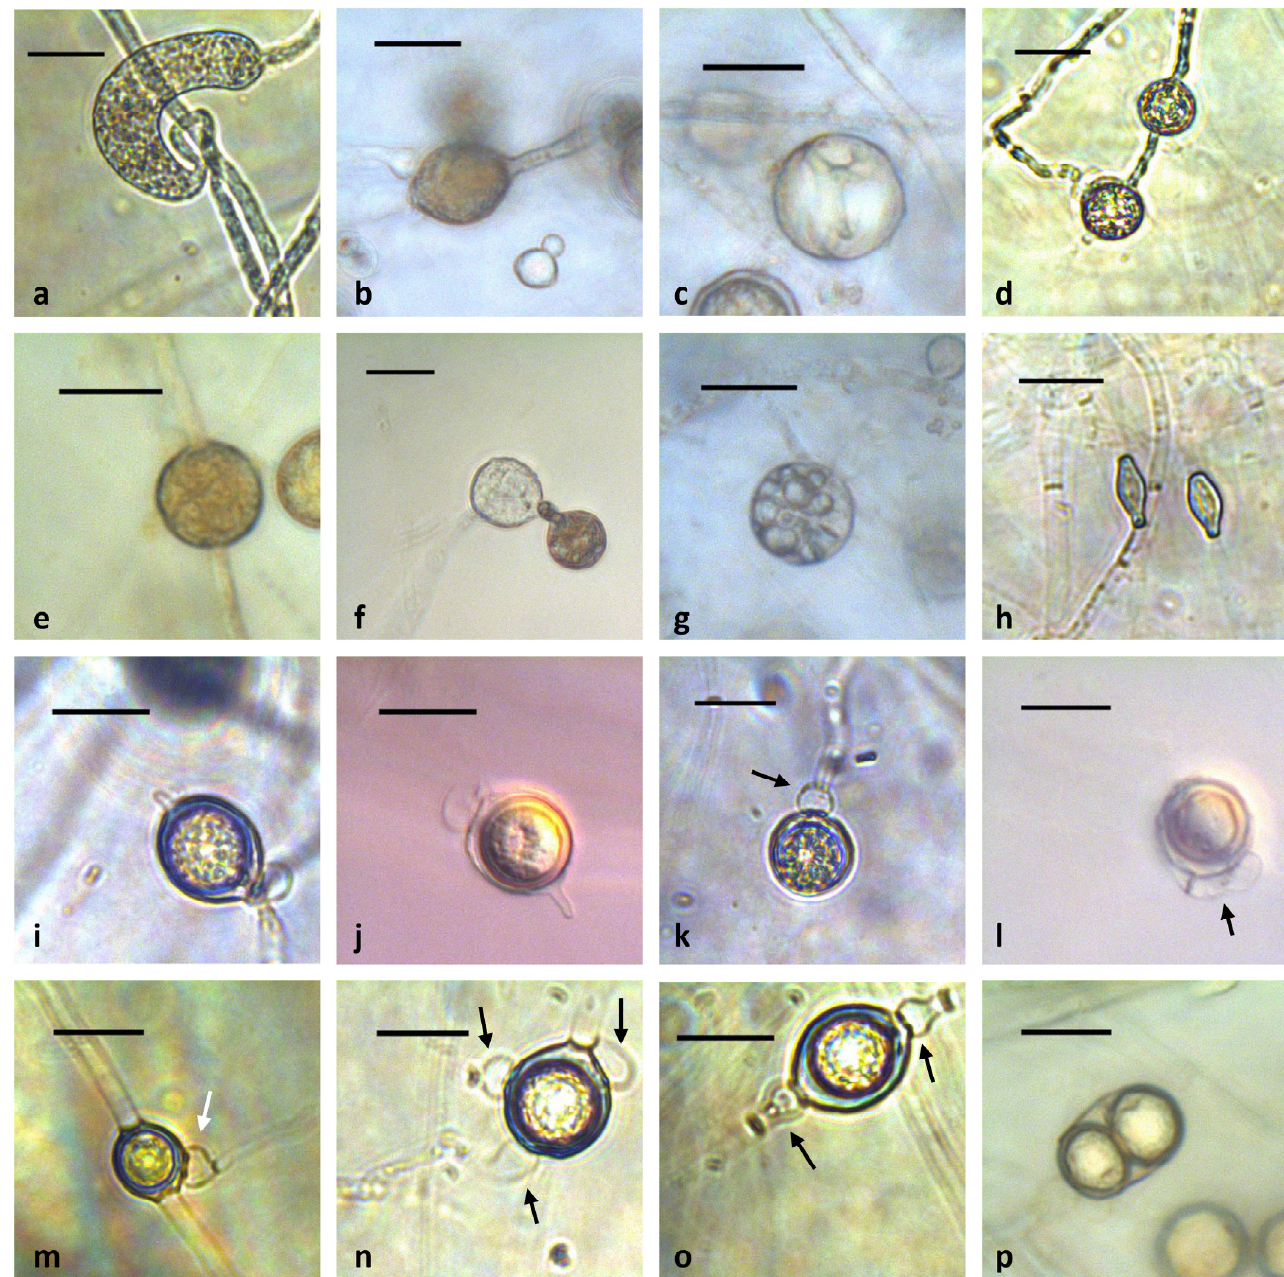
Figure 5. Morphological structures of Globisporangium commune sp. nov. ( a ) sausage-shaped appres- sorium; ( b ) lemon-shaped sporangium; ( c ) empty sporangium; ( d ) catenulate globose sporangia; ( e ) intercalary globose sporangium; ( f ) early stage of vesicle formation; ( g ) zoospores in vesicle; ( h ) doliiform hyphal swellings; ( i , j ) oogonium that contains aplerotic oospore with a papilla; ( k ) plerotic oospore with a hypogynous antheridium (arrow); ( l ) elongated antheridial cell (arrow) that makes broad contact with an oogonium; ( m ) intercalary oogonium with a diclinous antheridium (arrow); ( n ) aplerotic oospore with three antheridia (arrows); ( o ) intercalary oogonium with two monocli- nous antheridia (arrows); ( p ) two oospores in an oogonium. Scale bar: 20 µm.